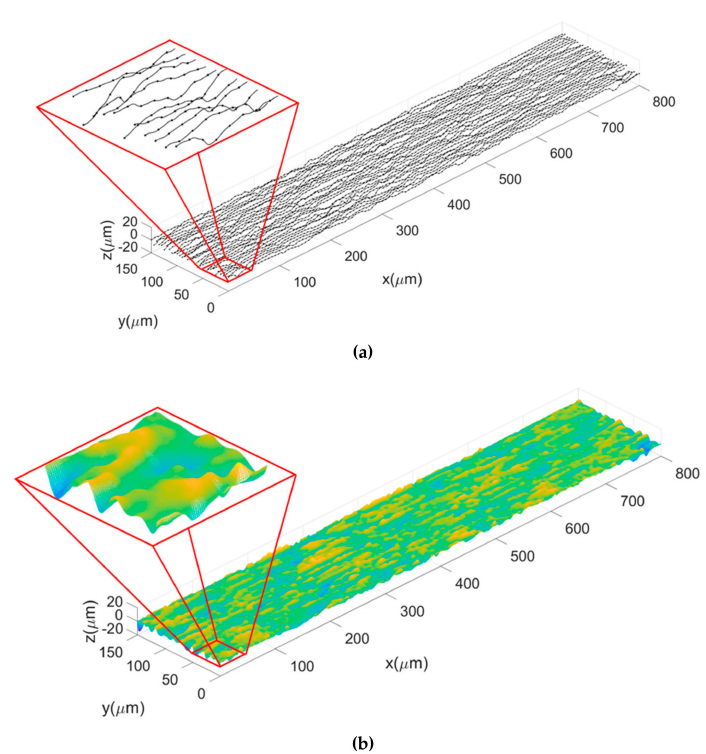
Figure 3. Measured profiles and the simulated surface of a rough specimen (Specimen No. 1): ( a ) measured profile data and ( b ) a generated NURBS surface.